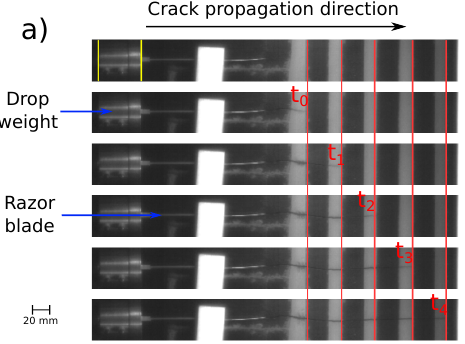
Figure 2. Fast camera images obtained with a sampling rate of 10 4 frames per second to visualize the rapid propagation of cracks in a PA11 strip specimen. The time t 0 is chosen as the reference point where the crack starts to propagate in dynamic regime. The time between two images is 10 − 4